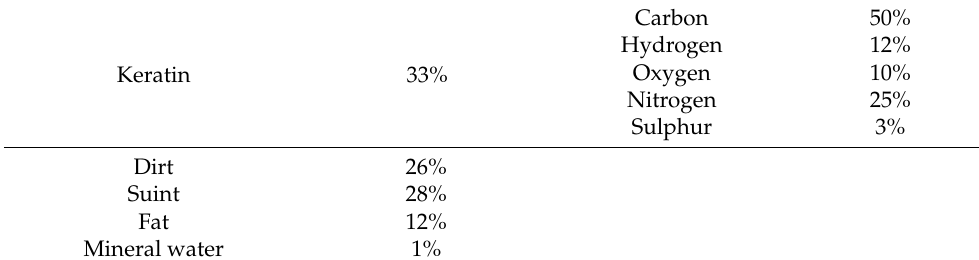
Table 1. Chemical composition of raw sheep wool [13].